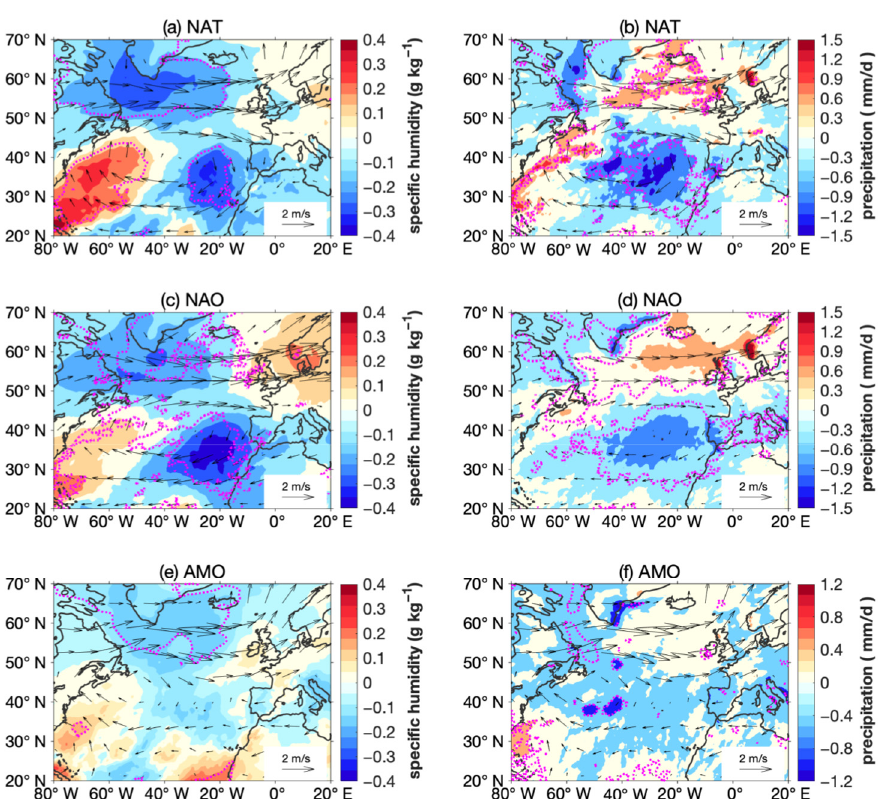
Figure 7. ( a ) Regression of specific humidity on 850 hPa (colors, g kg − 1 ) and wind velocity on 850 hPa (vectors, m s − 1 ) on NAT index. The second row ( c , d ) and third row ( e , f ) are the same as the first row ( a , b ) but for regression on NAO and negative AMO index, respectively. Purple contours mark the signal above 95% significance level.